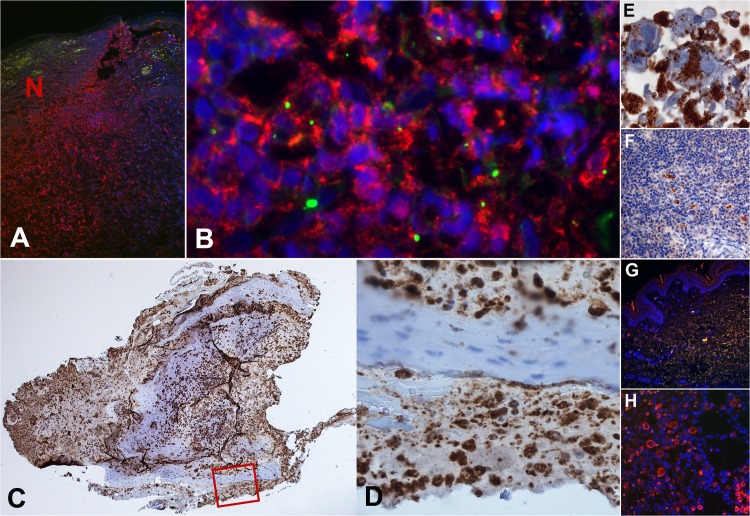
Neutrophils are prominent in the eschars of scrub typhus patients.The necrotic zone of a human eschar biopsy in a patient with scrub typhus is characterized by high-density neutrophil infiltrates with partially karyorrhectic neutrophils. Panel A: The granulocyte-dense zones are predominantly located adjacent to the central necrotic zone (N), at the dermal-epidermal junction and in superficial dermal infiltrates (anti-neutrophil elastase stained red, patient TM2193, magnification x400). Panel B: Immunofluorescence image of a neutrophil rich infiltrate of the upper dermis containing Orientia tsutsugamushi stained bright apple green (in-house anti-56kDa Orientia mAb) and neutrophils stained red (anti-CD15 antibody, Abcam By87), patient TM2193, magnification x600). Panels C and D: Immunohistochemical staining of neutrophils in brown, using anti-CD15 antibodies (Abcam By87). Panel D is an enlargement and corresponds to the red square insert, demonstrating the typical granulation of neutrophils. Patient TM 2644, magnification x100, insert x600. Panels E-H: Controls included anti-56kDa Orientia mAb positive control in heavily-infected L929 cells (immunohistochemistry, x600, panel E); anti-CD15 antibody (Abcam By87) positive control in uninfected human tonsil (immunohistochemistry, x400, panel F) and skin (immunofluorescence with anti-CD15 in red, x100, panel G); and anti-56kDa Orientia mAb negative control in chronically inflamed (psoriasis) human skin (immunofluorescence with HLADR in red and anti-56kDa in green, x400, panel F).